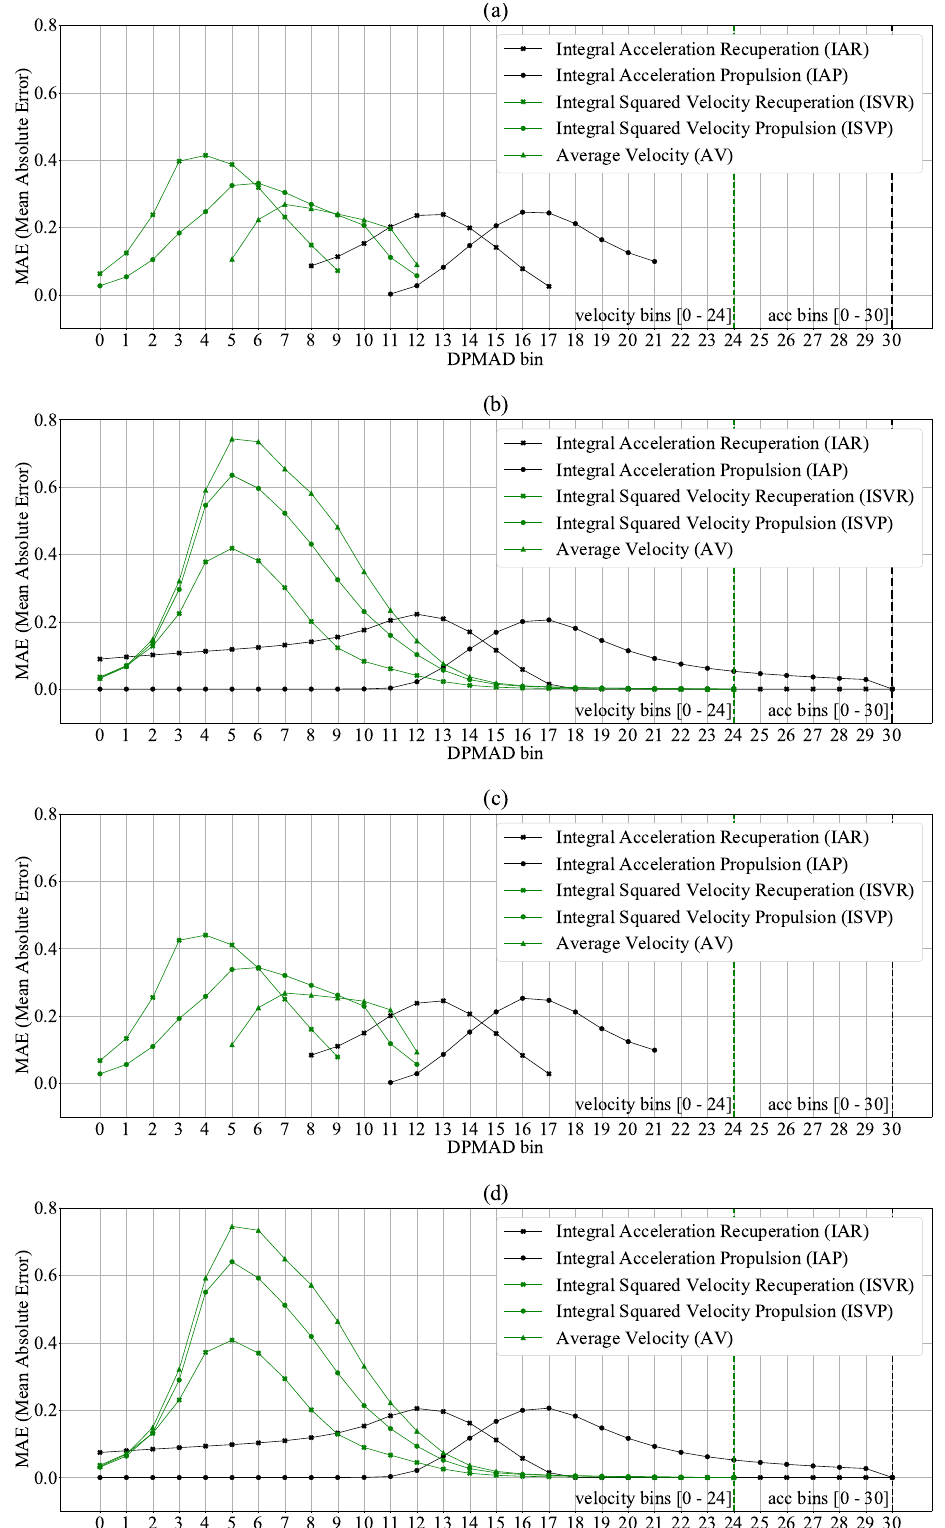
Figure 7. Mean Absolute Errors (MAE) for DPMAD bins using both machine learning (ML) model categories ( a , c ) regression and ( b , d ) classification. The problem scenario is LBCS, and the test scenario for panels ( a , b ) is CTS, whereas for panels ( c , d ) is